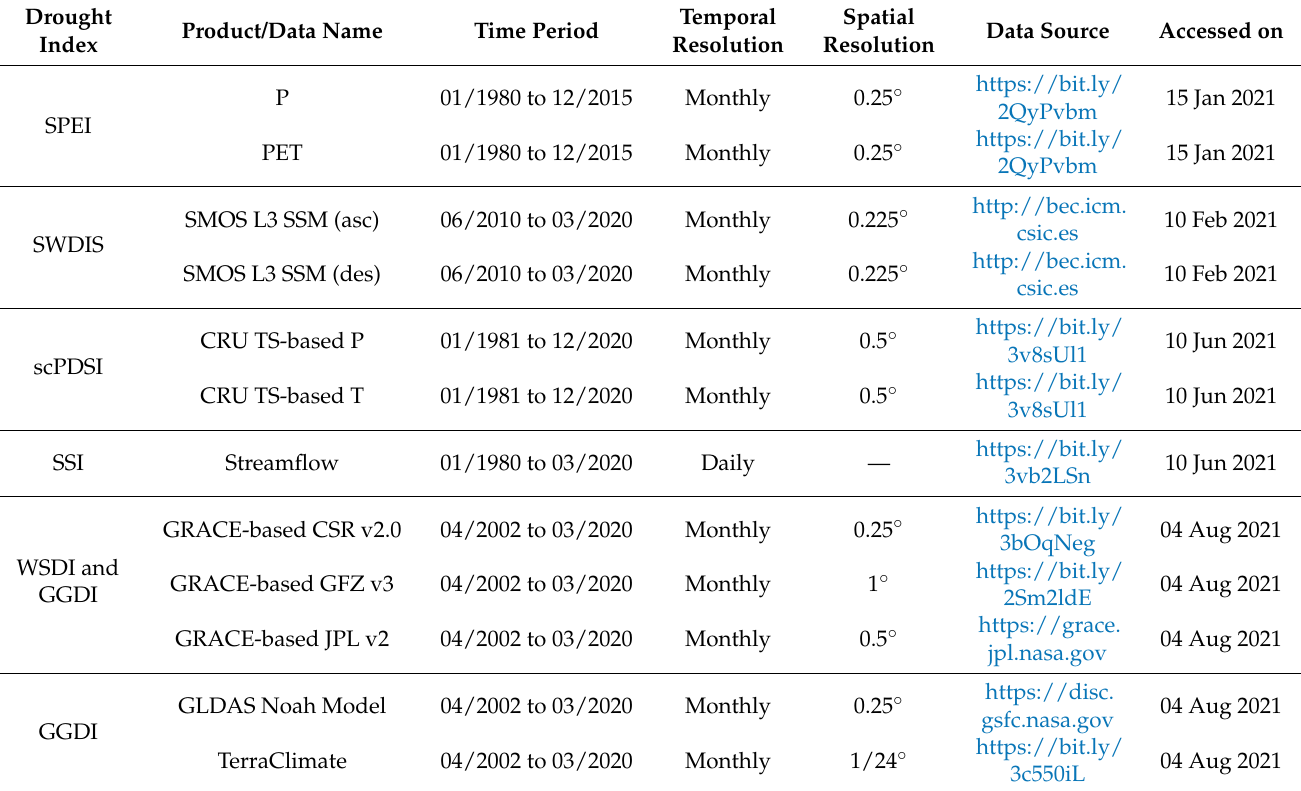
Table 1. Summary of the drought indices used in this study.